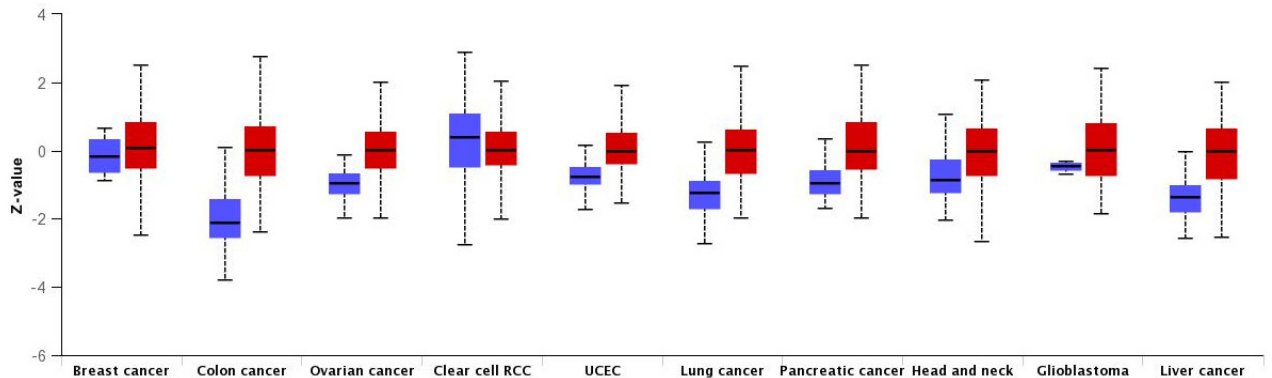
Figure 3. The HMGA1 protein levels in different cancer types compared to normal tissues investigated by UALCAN. Blue and red box plots indicate normal and tumor samples, respectively.